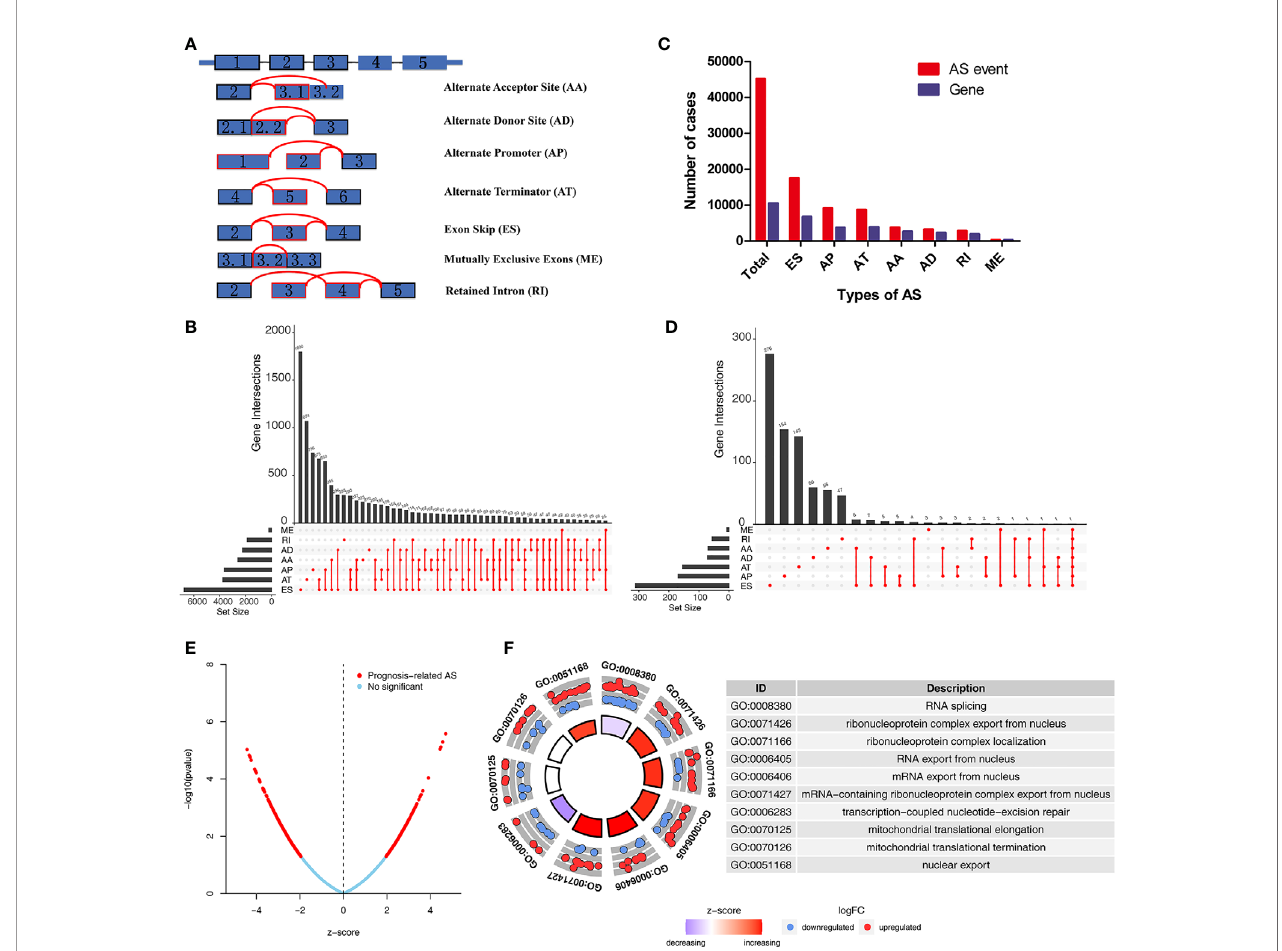
FIGURE 2 | Overview of AS events and Gene Ontology (GO) functional annotation analysis in TCGA THCA cohort. (A) Seven types of AS events were illustrated including exon skip (ES), retained intron (RI), alternate promoter (AP), alternate terminator (AT), alternate donor site (AD), alternate acceptor site (AA), and mutually exclusive exons (ME). (B) Numbers of AS events and AS-associated genes in THCA patients. (C) Upset plot of interactions among seven types of all AS events in THCA. (D) Upset plot of interactions among seven types of survival-associated AS events in THCA. (E) Volcano plots of prognostic AS events. (F) Results of GO functional annotation analysis. The outer circle shows a scatter plot for each term of the logFC of the assigned genes. Red circles display up-regulation pathways, and blue circles showing the down-regulation pathway. AS, alternative splicing; THCA, Thyroid Carcinoma; TCGA, The Cancer Genome